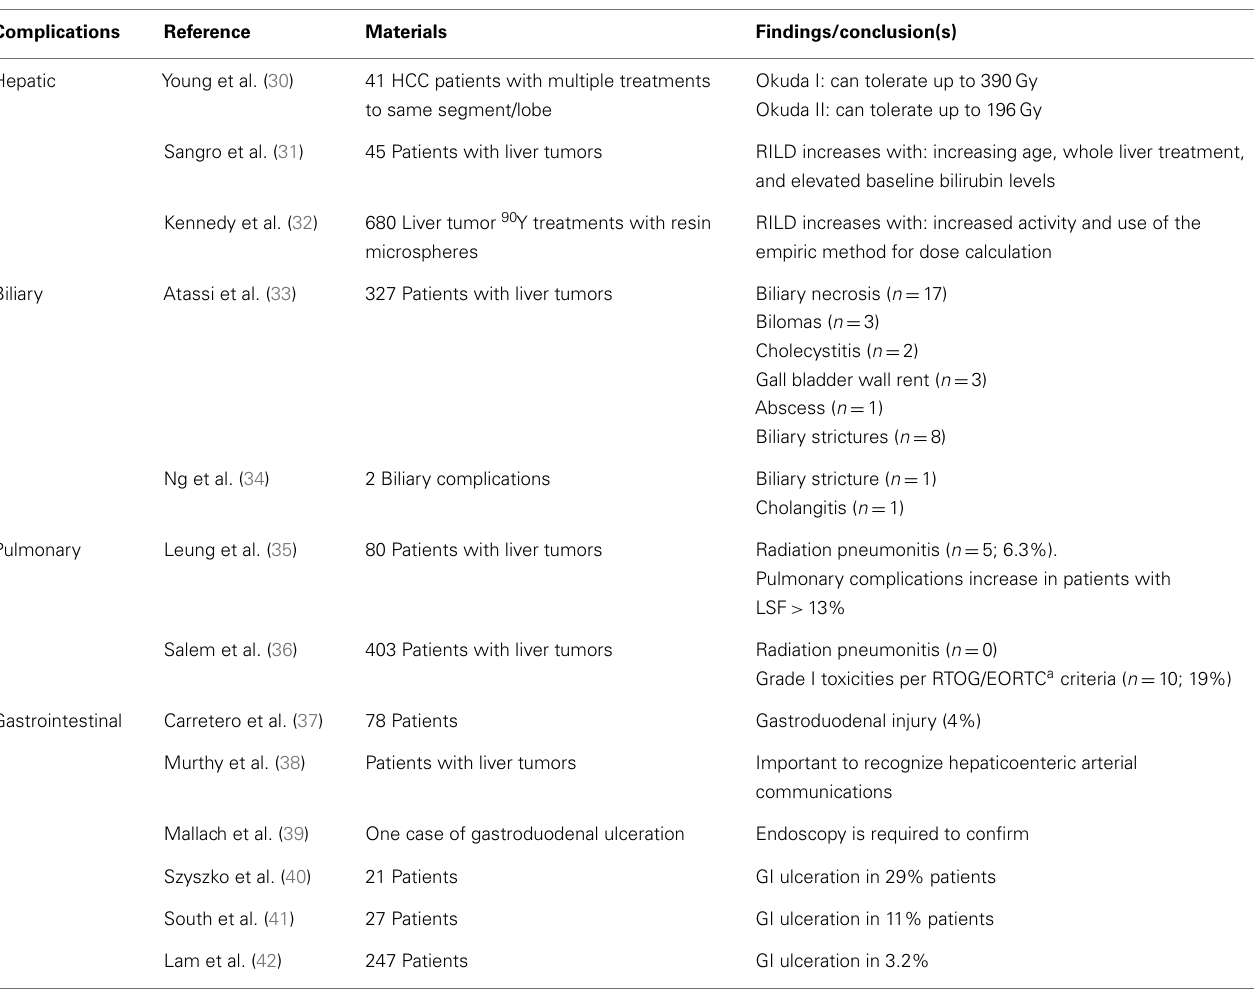
Table 2 | Summary of available data on post-radioembolization complications